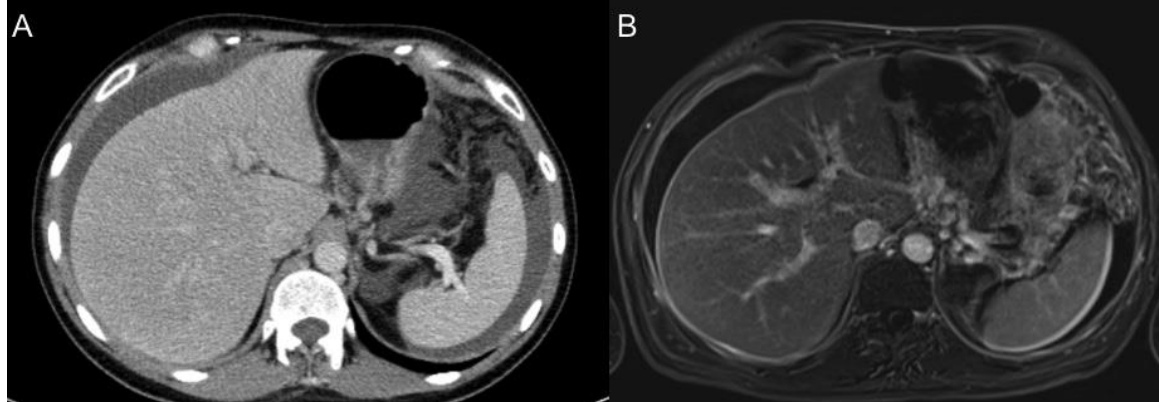
Figure 14. Gadolinium-enhanced MR sequences ( B ) are very efficient for showing supramesocolic peritoneum involvement. Contrast-enhanced CT ( A ) does not show the diffuse parietal and visceral peritoneal involvement.